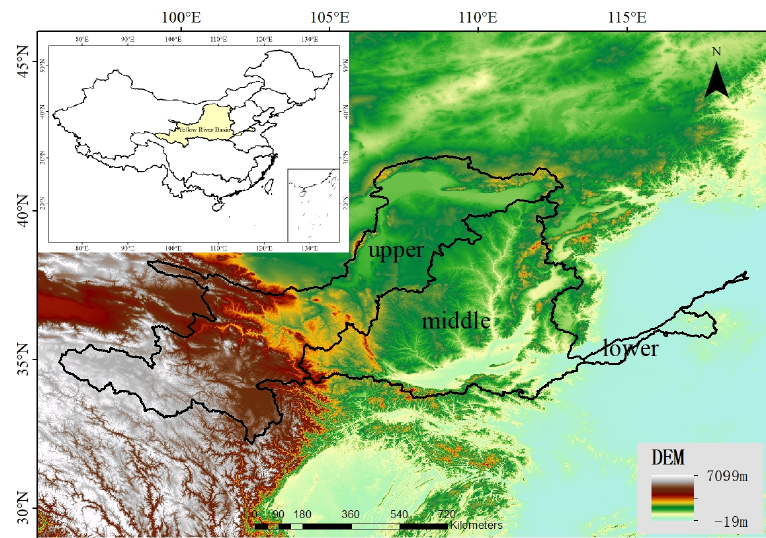
Figure 1. Location of the Yellow River basin.